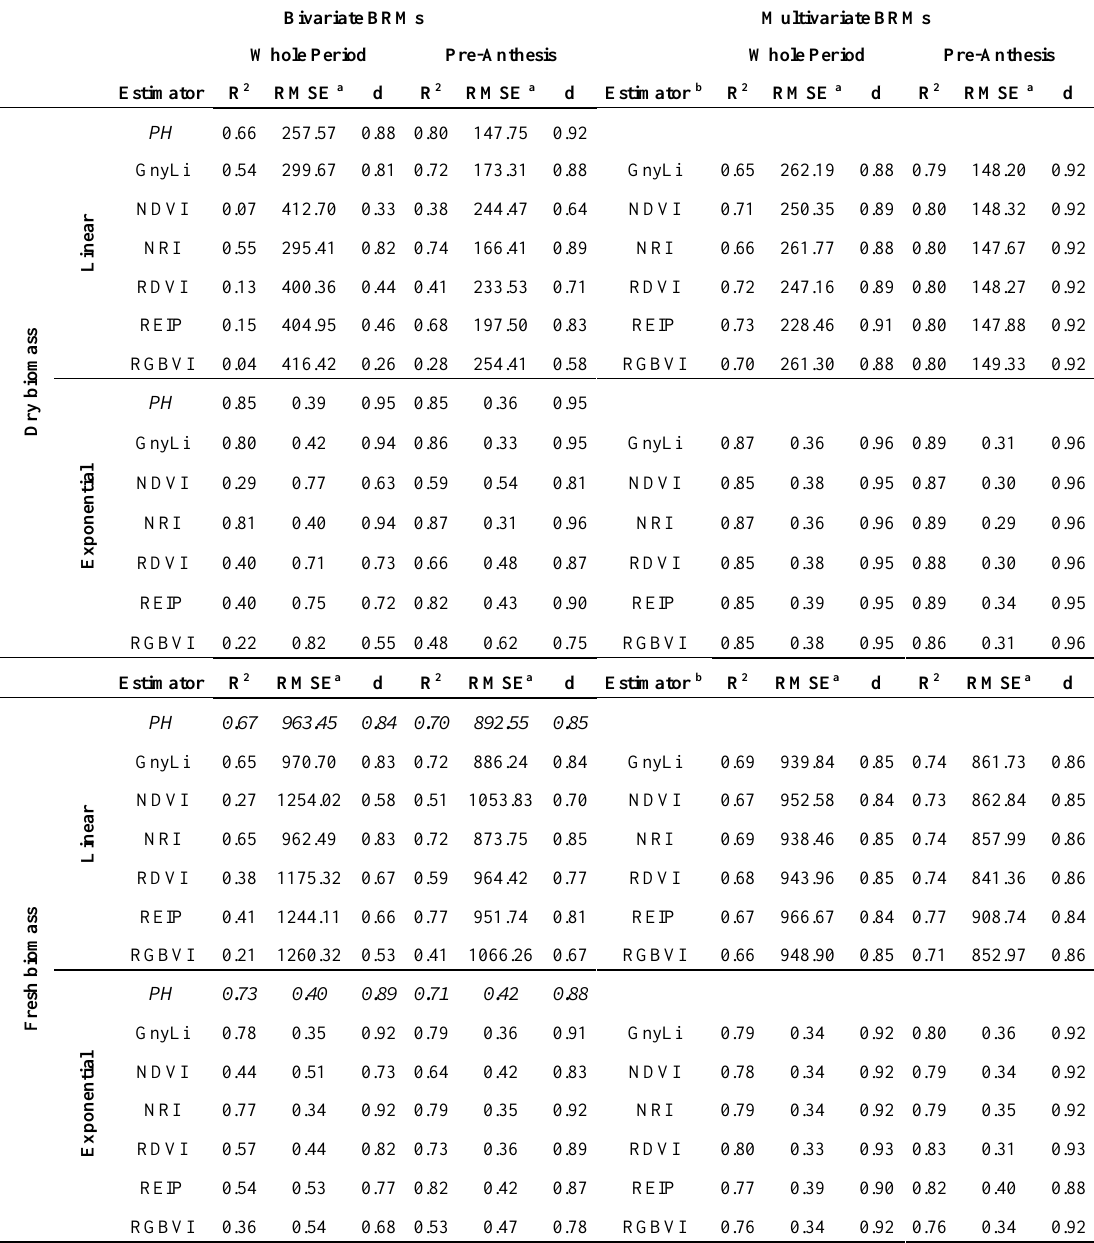
Table 6. Statistics for the model validation as mean values of the four subset combinations (R 2 : coefficient of determination; RMSE: root mean square error (g/m²); d: Willmott’s index of